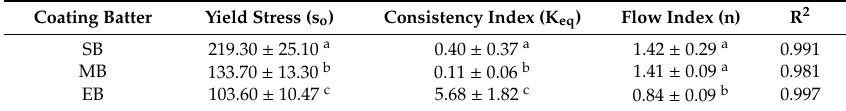
Table 2. Rheological characteristics of the di ff erent batter formulations fitted to the Herschel– Bulkley model. Coating Batter Yield Stress (s o ) Consistency Index (K eq